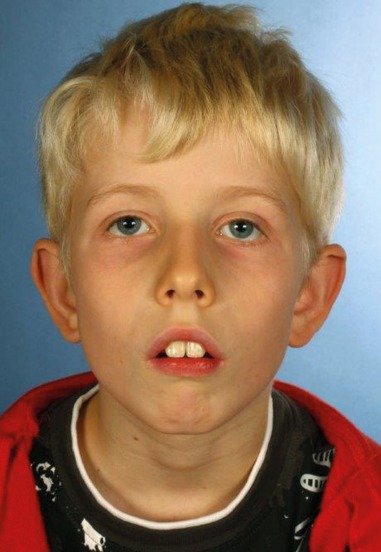
Adenoid face with orofacial dysfunction (myofunctional syndrome) with reduced orofacial tonus. As a consequence, open mouth, compensatory tension of the mental muscle, tired expression.